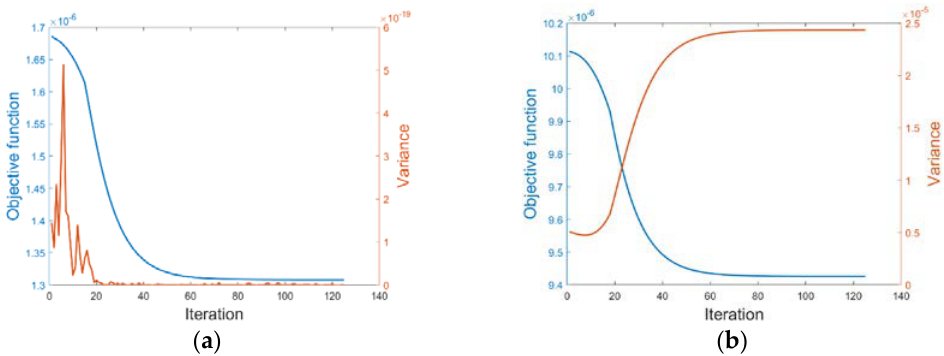
Figure 8. Convergence curve of the objective function and variance constraint of the ( a ) hexagonal type; and ( b ) triangular type.